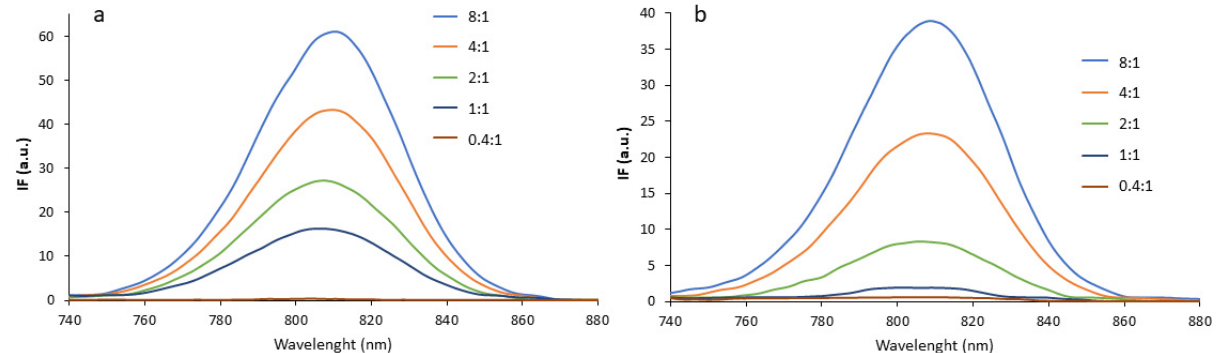
Figure 5. Fluorescence spectra of ICG after interaction with NPs ( a ) and with CS ( b ) at different ICG:CS molar ICG:CS molar ratios.